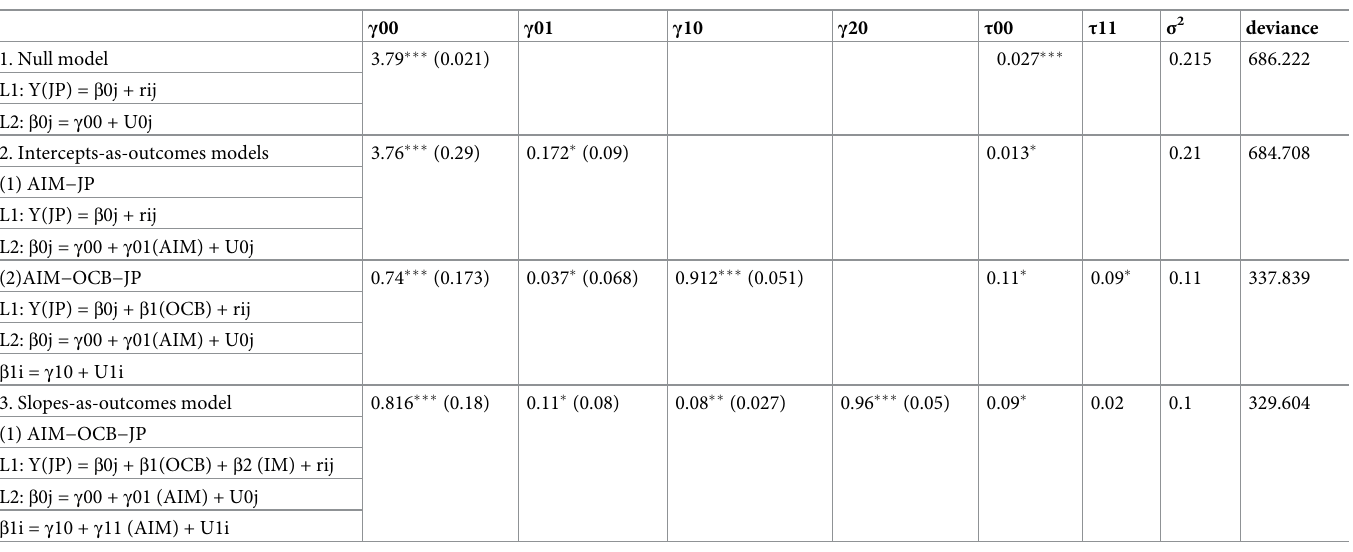
Table 6. Hierarchical linear model of the various